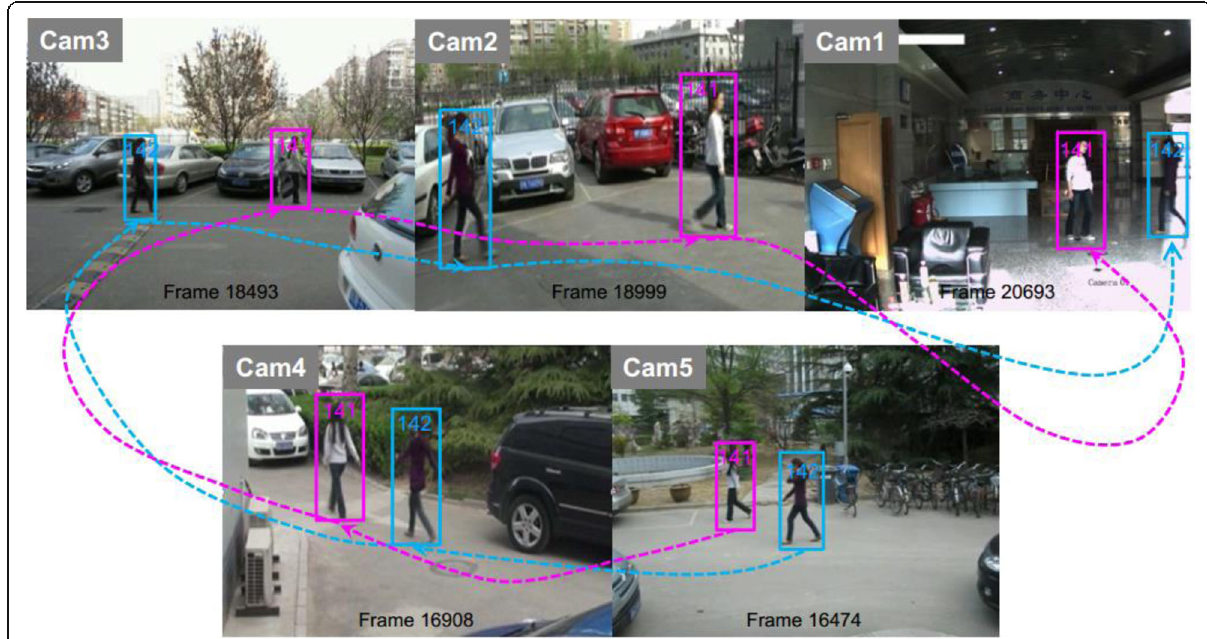
Fig. 14 Illustration of human tracking results across non-overlapping in cameras on NLPR 4. Bounding boxes with the same color indicate the same human, and the dashed lines illustrate the trajectories generated by human targets walking across different cameras